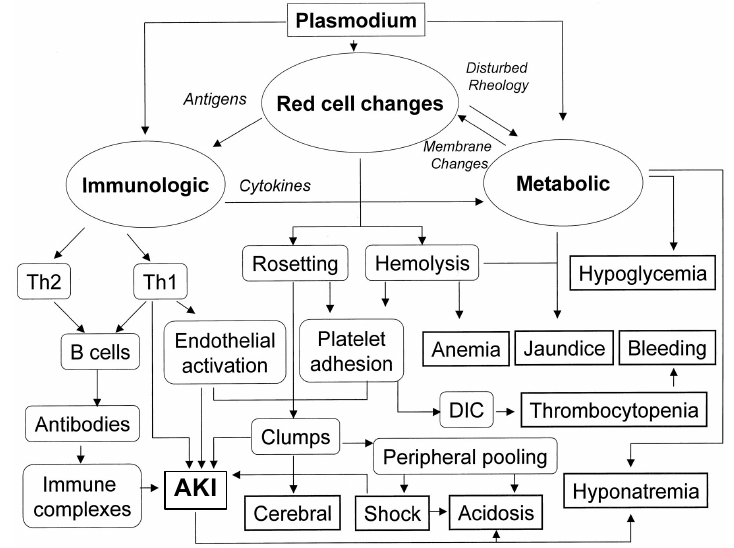
Figure 2. Pathways involved in pathogenesis of severe malaria. Modified from 44, with permission.